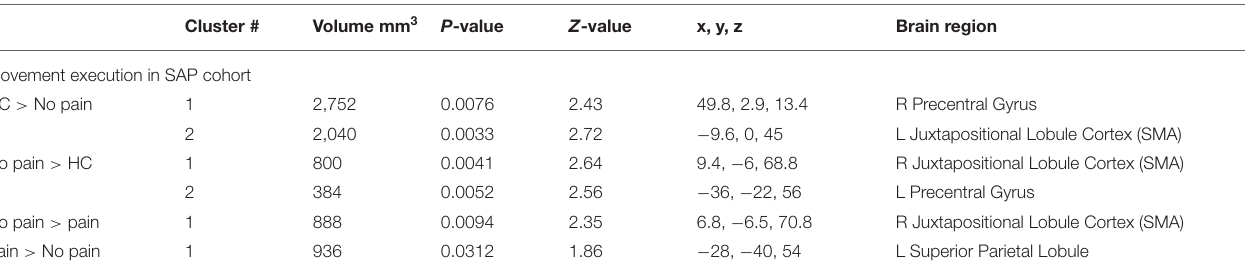
TABLE 6 | Activated brain regions within each between-group contrast for SAP performing a movement execution task. Cluster # Brain region Movement execution in SAP cohort